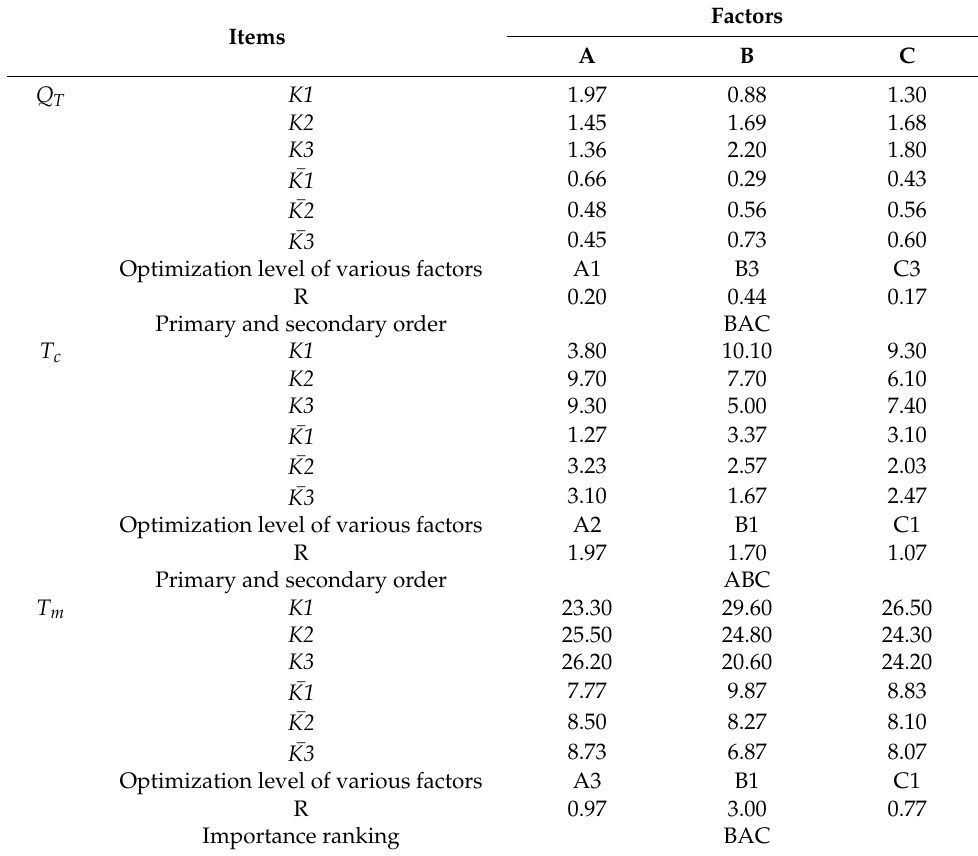
Table 7. Multi-index range analysis of orthogonal experimental